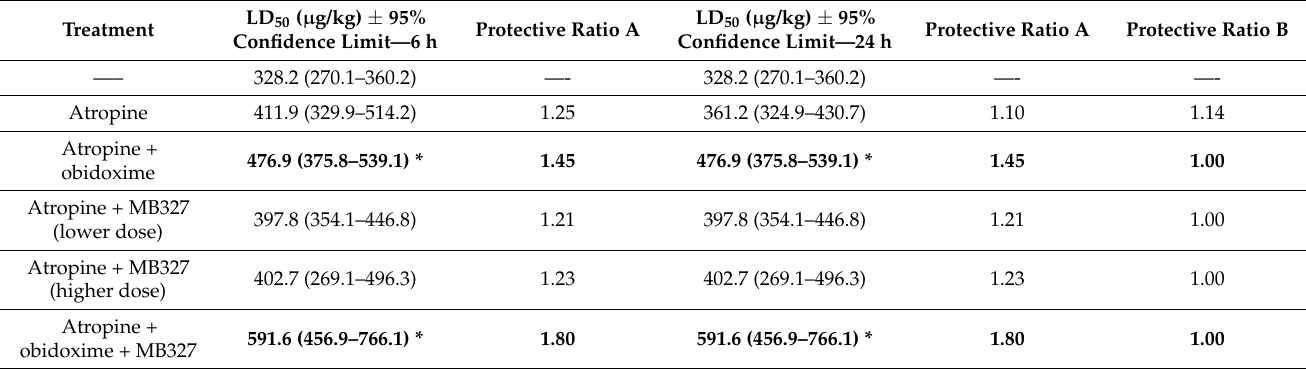
Table 1. The effect of experimental endpoint on the protection provided against lethal effects of sarin in